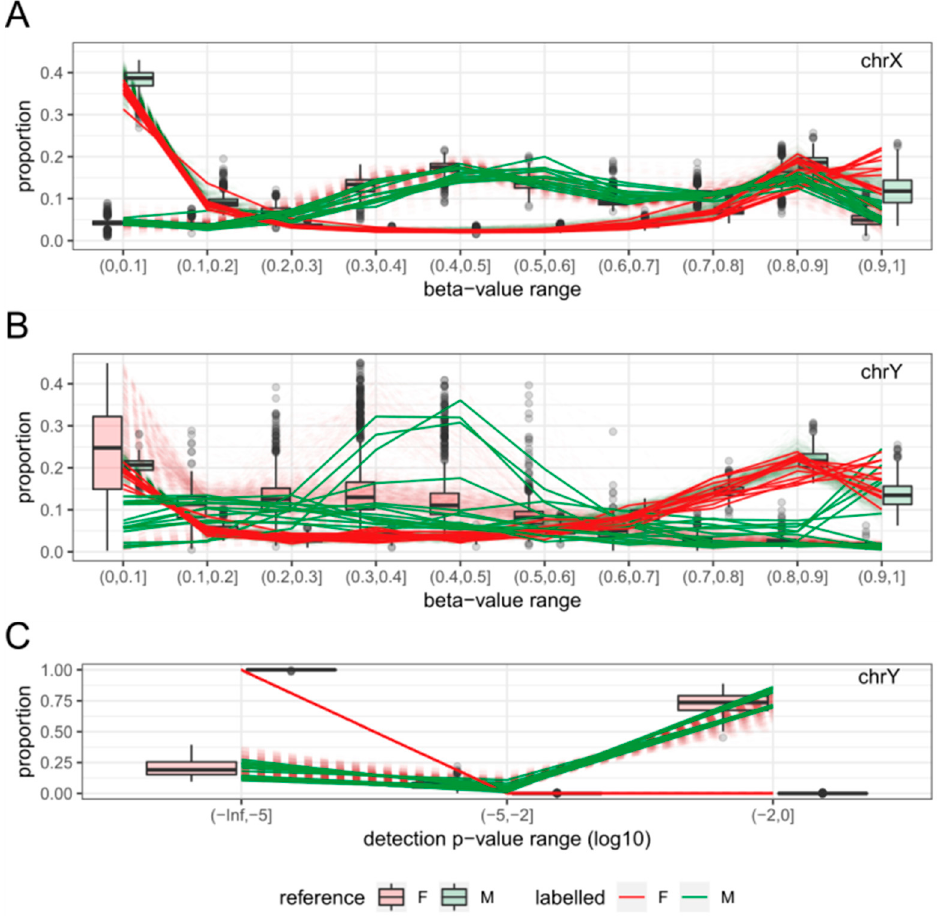
Figure 4. Beta-value/detection p -value distributions of discordantly predicted samples. The reference sample patterns are shown in boxplots on top of dashed lines in blurred red (F, Female) and green (M, Male), and those of discordant samples are shown in solid lines in the colours noted in the legend. Discordant males (predicted as F) follow the pattern of female reference samples, and discordant females (predicted as M) follow the pattern of male reference samples. ( A ) Distribution profiles of beta-values on chrX. ( B ) Distribution profiles of beta-values on chrY. ( C ) Distribution of detection p -values on chrY.